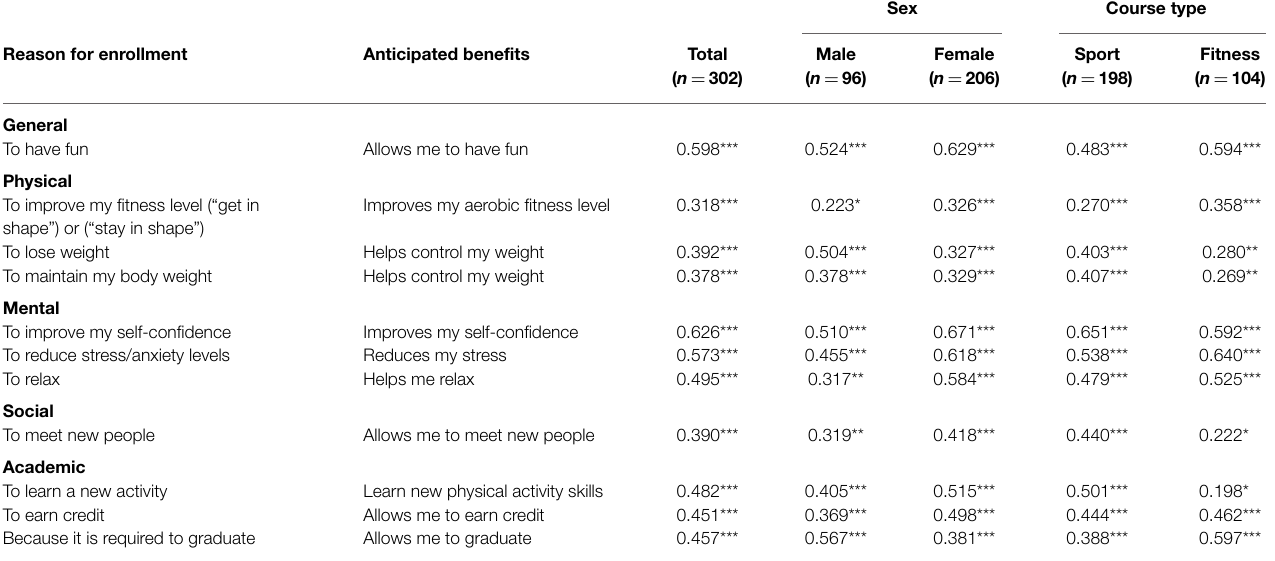
TABLE 4 | Kappa statistics measuring correlation between reasons for course enrollment and anticipated benefits